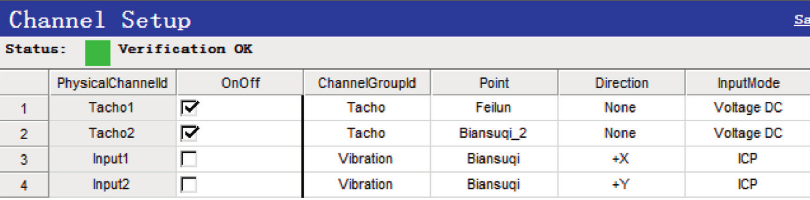
Figure 25: Measurement channels setting.